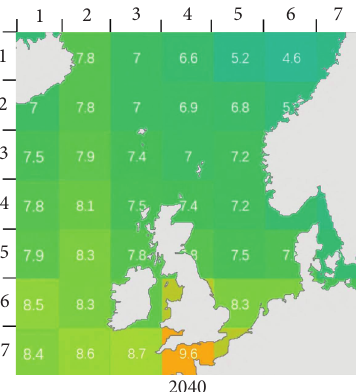
Figure 15: The predicted annual average sea temperature of the study area in 2030 temperature of the study area in 2040.